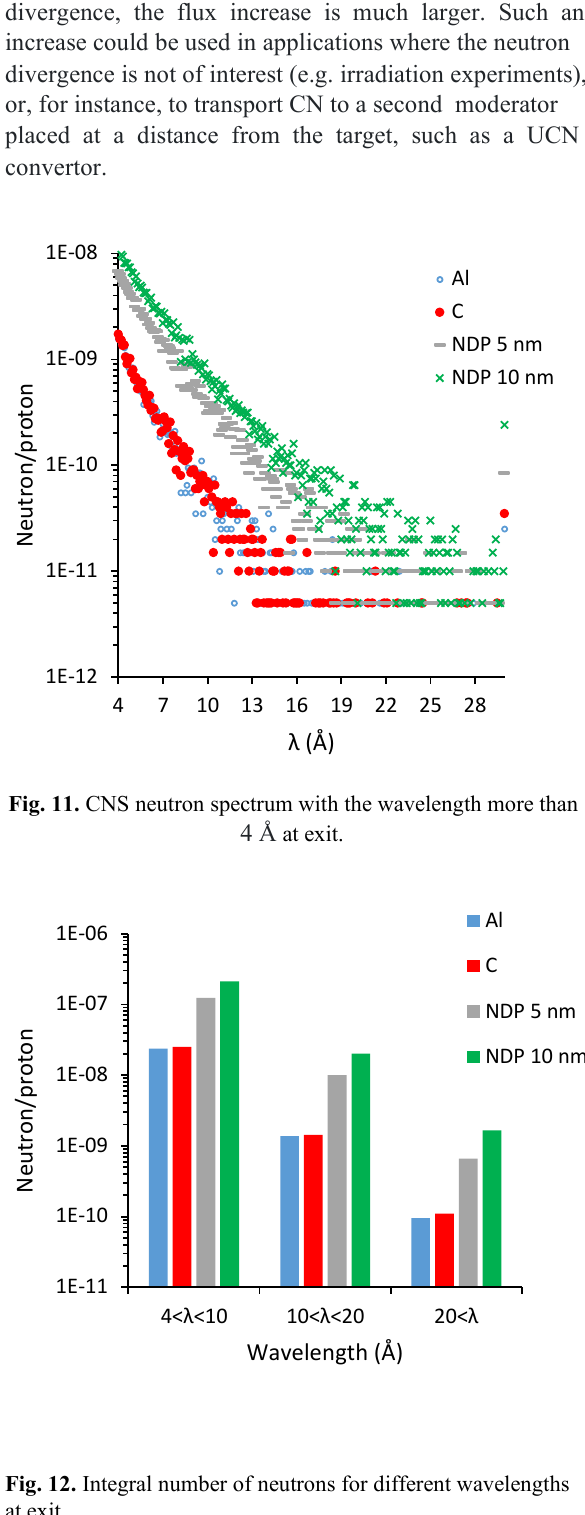
Fig. 12. Integral number of neutrons for different wavelengths at